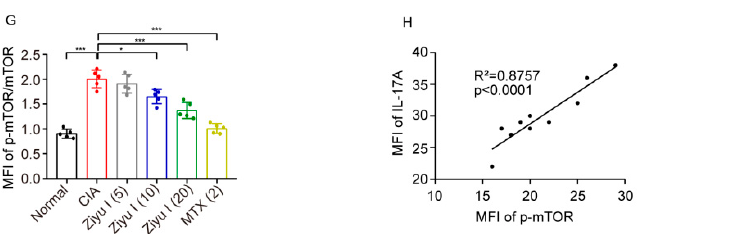
Figure 6. Ziyu I treatment reduces the activation of mTOR in T cells of CIA mouse. ( A ). The relative expression of Akt, mTOR, and p-Akt, p-mTOR in splenic T cells from normal mice, CIA mice, and 10 mg/kg Ziyu I treatment group of mice ( B ). The analysis of Akt/GAPDH expression ( C ). The analysis of p-Akt/Akt expression ( D ). The analysis of mTOR/GAPDH expression ( E ). The analysis of p-mTOR/mTOR expression ( F ). Representative immunofluorescence images of mTOR, p-mTOR, and IL-17A labeling in spleen tissue of treated mice ( G ). The mean fluorescence intensity of p-mTOR/mTOR in the spleens of mice was analyzed by immunofluorescence ( H ). Correlation analysis between MFI of p-mTOR and MFI of IL-17A in the spleen tissue of CIA mice. The data are presented as mean ± SD, n = 5. * p < 0.05, ** p < 0.01, *** p < 0.001 vs.